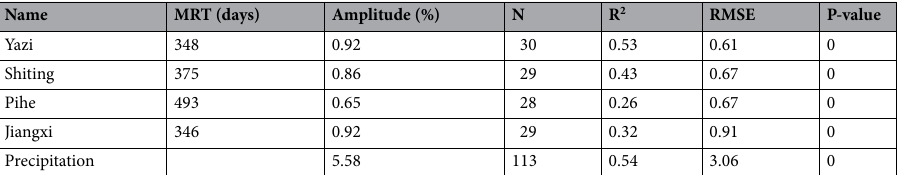
Table 3. Residence times (days) estimated from regression analysis for isotope data of precipitation and river water. N is the number of water samples. RMSE is the root mean square error of